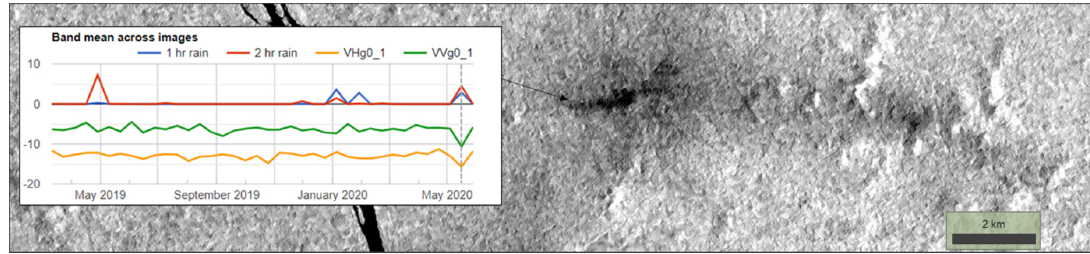
Figure 16. Anomalies in Sentinel-1 backscattering measurements due to heavy rainstorms can produce false deforestation alerts. In the figure, a deforestation warning, measuring 359 ha. was related to a heavy-rain episode registered by Global Precipitation Measurement (GPM) records (left panel, the vertical dashed line shows the date of the image). Other peaks in rain profiles did not provoke anomalies. This is due to the difference in the resolution of the SAR data (20 m) and the GPM data (~5 km).